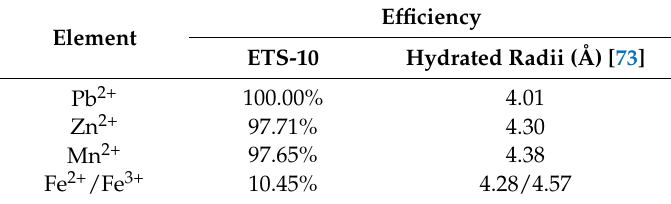
Table 8. Hydrated radius of the ions and corresponding metals removal efficiency of ETS-10